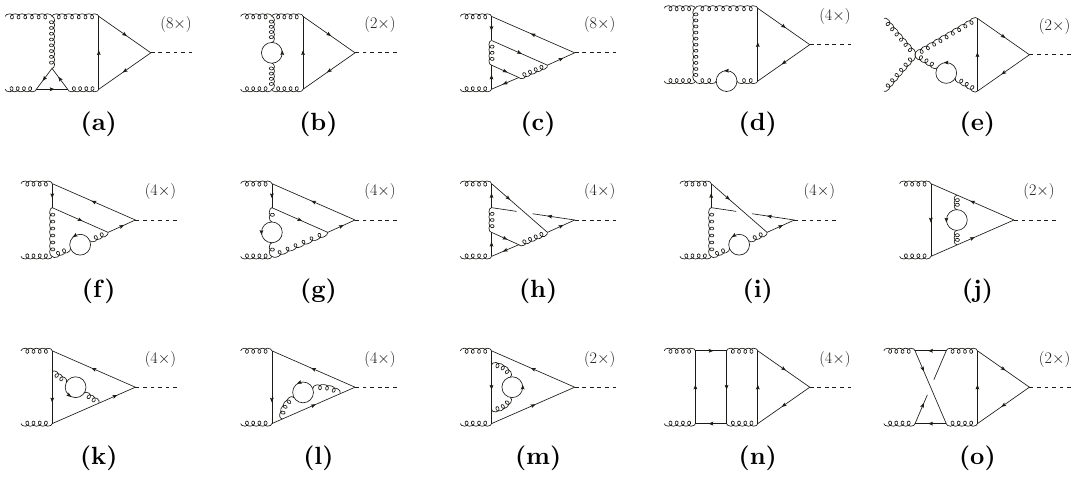
Figure 1 . Feynman diagrams for ggH contributing to the light-quark contribution. Diagrams with reversed fermion (cid:13)ows or swapped external vector bosons are not shown but indicated by the multiplicity in the top right corner of each diagram. Only diagrams (j){(o) contribute to the light-quark terms of (cid:13)(cid:13)H with the external gluons replaced by photons. R -gauge with the help of q2e [30, 31] the diagrams are mapped to a set of seven topologies (cid:24) via exp [30,